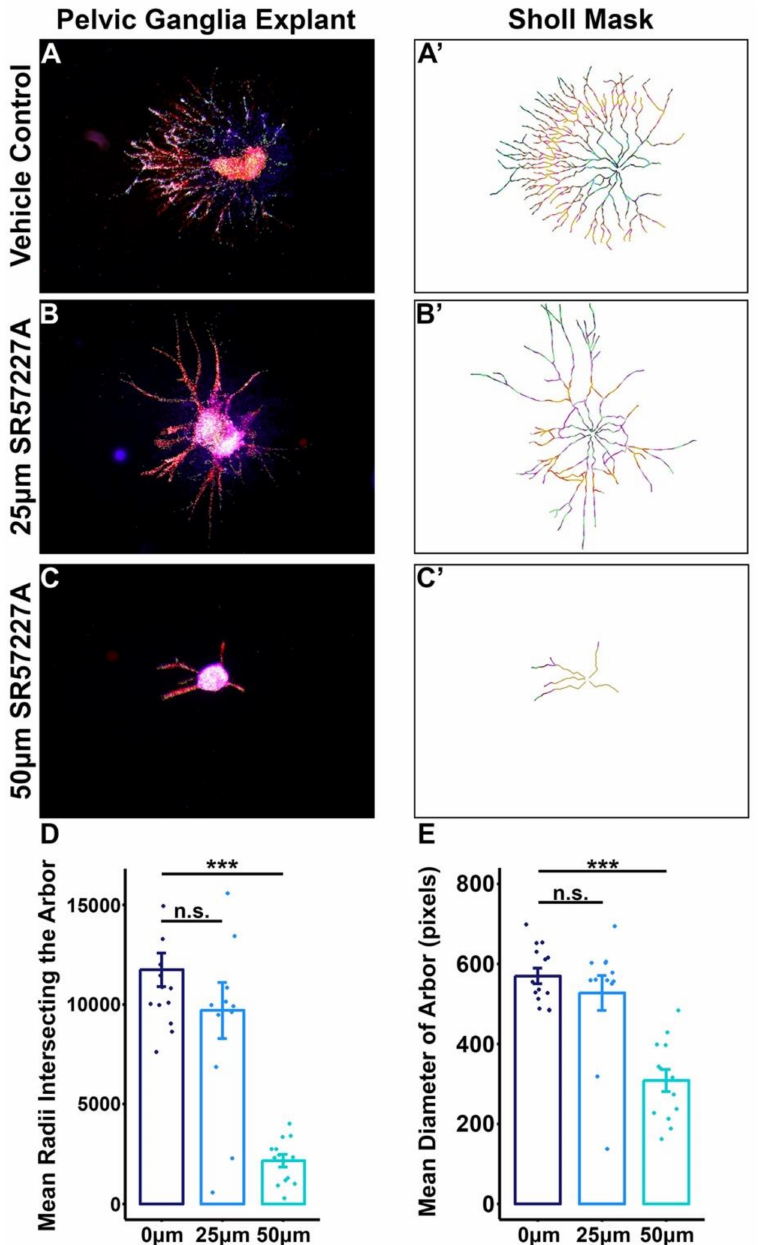
Figure 5. Over-stimulating 5-HT3 in cultured fetal pelvic ganglia explants diminishes neurite arbor complexity. Sox10 -H2BVenus 13.5 dpc pelvic ganglia explants treated with 5-HT3 receptor agonist SR57227A exhibit a severe reduction in the elaboration and complexity of neuronal processes compared to vehicle control. ( A – C ) Fluorescent microscope images of pelvic ganglia explants treated with drug vehicle ( A ), 25 µ m SR57227A ( B ), or 50 µ m SR57227A ( C ). ( A’ – C’ ) Sholl masks generated for pelvic ganglia explant neuronal fiber tracings that demarcate concentric radii used to quantify neurite arbor complexity and growth. ( D ) Average number of intersections of the neurite arbor with Sholl radii plotted for each treatment group. ( E ) Average diameter of the outer-most circle drawn that encompasses the entire arbor. For both plots, black brackets are SEM. n = 12–14 pelvic ganglia explants per treatment group. *** = p < 0.001, n.s. = not statistically significant, assessed via one-way ANOVA with Tukey’s Honest Significant Difference test to correct for multiple